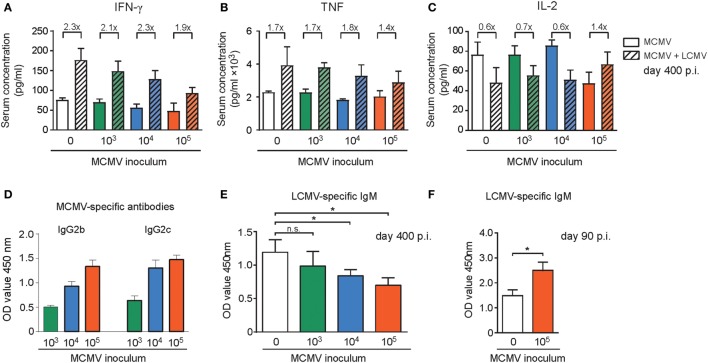
The inflammatory milieu and antibody levels upon heterologous infection are shaped by the inoculum dose of mouse CMV (MCMV). (A–E) Wild-type (WT) mice were kept uninfected or infected with 103, 104, or 105 PFU MCMV-Smith (n = 16 mice per group), and at day 400 post-infection 8 mice per group were challenged with 2 × 105 PFU lymphocytic choriomeningitis virus (LCMV)-Armstrong. At day 8 post LCMV infection, mice were analyzed and compared with uninfected littermate controls. Cytokines and chemokines in the serum were determined by mouse cytokine bio-plex immunoassays (A–C), and MCMV (D) or LCMV-specific (E,F) antibody levels were determined by ELISA. (A–C) Shown are the serum concentrations of IFN-γ (A), TNF (B), and IL-2 (D). MCMV-specific IgG antibody levels in LCMV unchallenged mice (E) Levels of LCMV-specific IgM antibodies in LCMV-challenged mice. (F) WT mice were kept uninfected or infected with 105 PFU MCMV-Smith, and at day 90 post-infection mice were challenged with 2 × 105 PFU LCMV-Armstrong. Blood was taken 8 days after LCMV infection and levels of LCMV-specific IgM antibodies within the serum were determined. Data represents mean values + SEM (n = 8 per group, *P < 0.05). Data were pooled from two independent experiments.